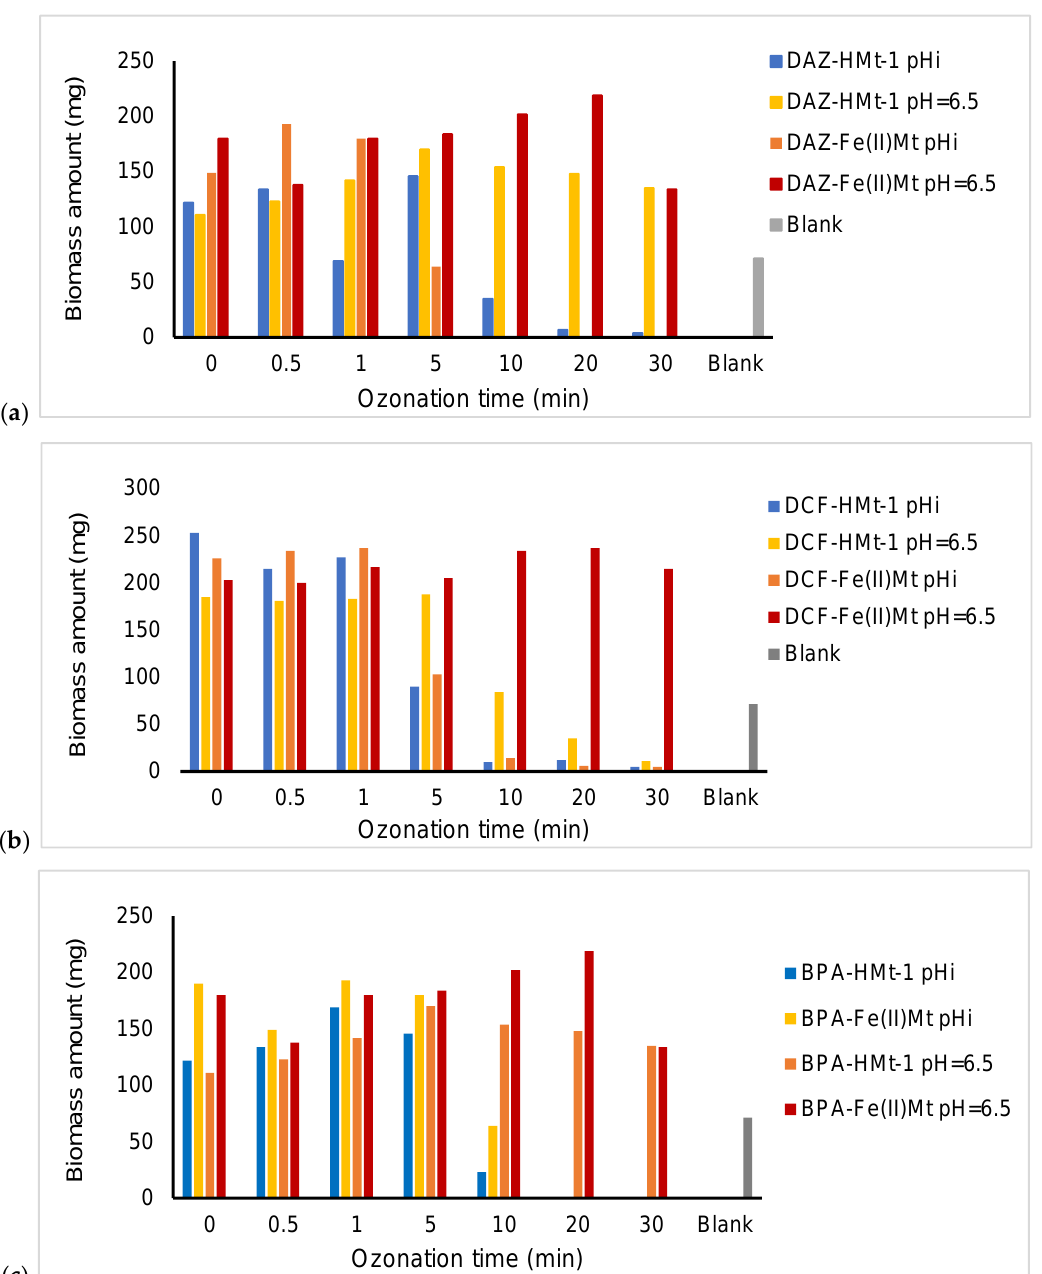
Figure 9. Effect of the ozonation time of the aqueous solutions of DAZ ( a ), DCF ( b ) and BPA ( c ) on the biomass amount (BA) of Lemna minor . Ozone throughput: 600 mg h −1 , Catalyst amount: 40 mg; Aliquot volume = 30 mL. The control sample contains only Lemna minor and was not contacted with ozonation mixtures. The toxicity tests were achieved i . at constant pH 6.5 adjusted after ozonation and ii . at the pH of the SIS mixture with the solution of the organic substrate before and after ozonation at different times.